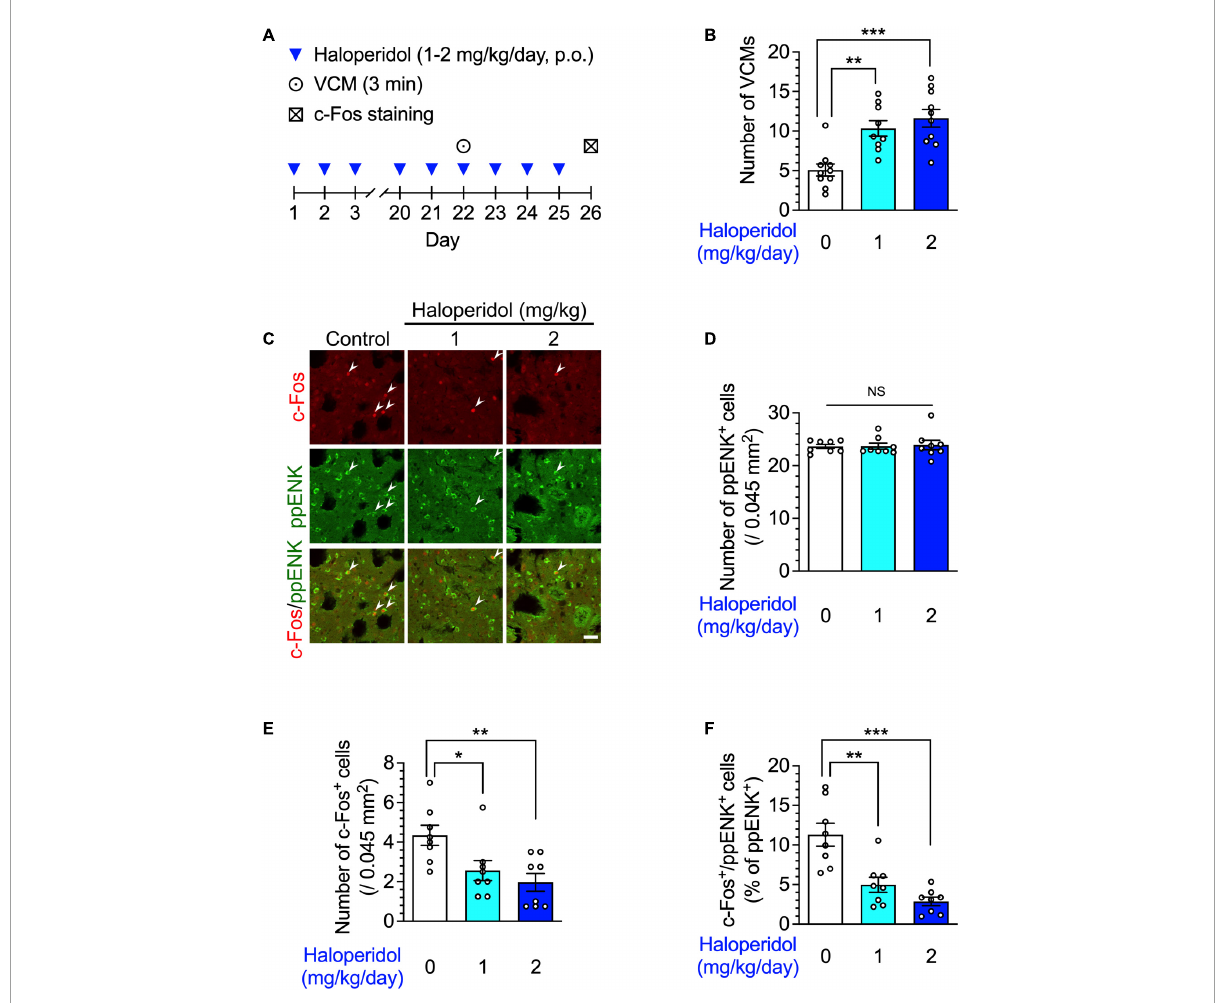
FIGURE1 Orofacial dyskinesia and dorsostriatal indirect pathway medium spiny neuron (iMSN) activity in mice after repeated treatment with haloperidol. (A) Experimental protocol for counting vacuous chewing movements (VCMs) and immunostaining iMSNs. (B) Mice ( n = 9–10 per group) were treated daily with oral haloperidol (1 or 2 mg/kg/day) for 21 days. The VCMs were counted for 3 min at the 24 h after the last treatment. Statistical significance was tested using one-way analysis of variance (ANOVA) with a post hoc Tukey’s test. ** P < 0.01; *** P < 0.001. ( C–F , n = 8 per group) After the VCM experiments, the daily haloperidol treatment was continued for 4 more days; on day 26, coronal sections containing the dorsal striatum in mice were prepared, stained with anti-c-Fos and anti-preproenkephalin (ppENK) antibodies, and imaged using confocal microscopy. The number of (D) ppENK + cells and (E) c-Fos + cells were counted. (C,F) The number of c-Fos + /ppENK + cells (shown by arrowheads) were counted and are presented as percentages of the number of ppENK + cells, reflecting the total number of iMSNs.